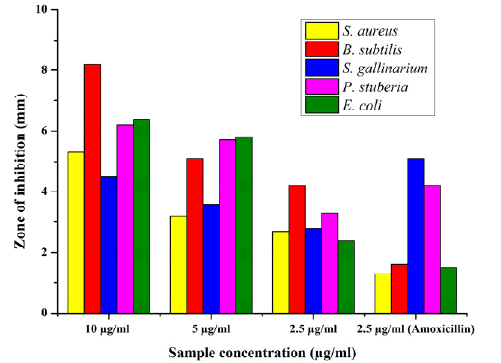
Fig. 4. Antibacterial activity of PSLASNPs